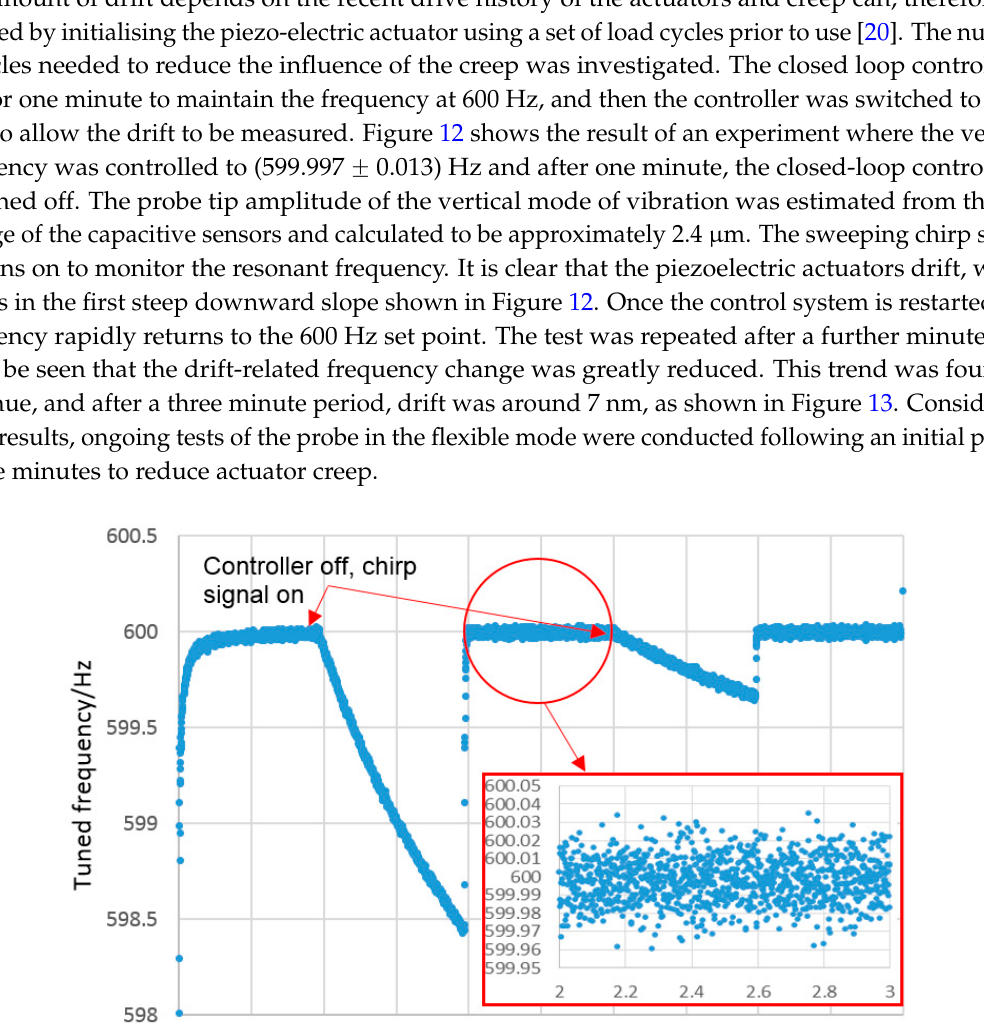
Figure 13. Frequency plot showing the magnitude of the stylus tip drift as a result of the impact of actuator creep at the flexible mode (600 Hz). This drift at the stylus tip and the tuned frequency in Figure 12 were measured at the same time. Using the transfer function described in Equation (4) (see below), the impact of actuator creep on the stylus tip displacement was calculated. From Figure 13, it can be seen that after one and three minute periods, the actuator creep is around 35 nm and 7 nm at the stylus tip respectively. It is clear that the creep in three piezo-electric actuators was reduced as a result of repeating and recycling after a further minute. In order to investigate the sensitivity of the probing system in the flexible mode, it was calibrated using the same procedure as for the stiff mode. The position of the nano-positioning stage was maintained between the calibration of the stiff and flexible mode in each direction to minimise error. The calibration was completed within one minute, reasonably limiting drift to less than 6 nm, as described above. Figure 14a,b show the calibration time against the output voltage from the three capacitive sensors for displacement in the first and second directions respectively. The step height